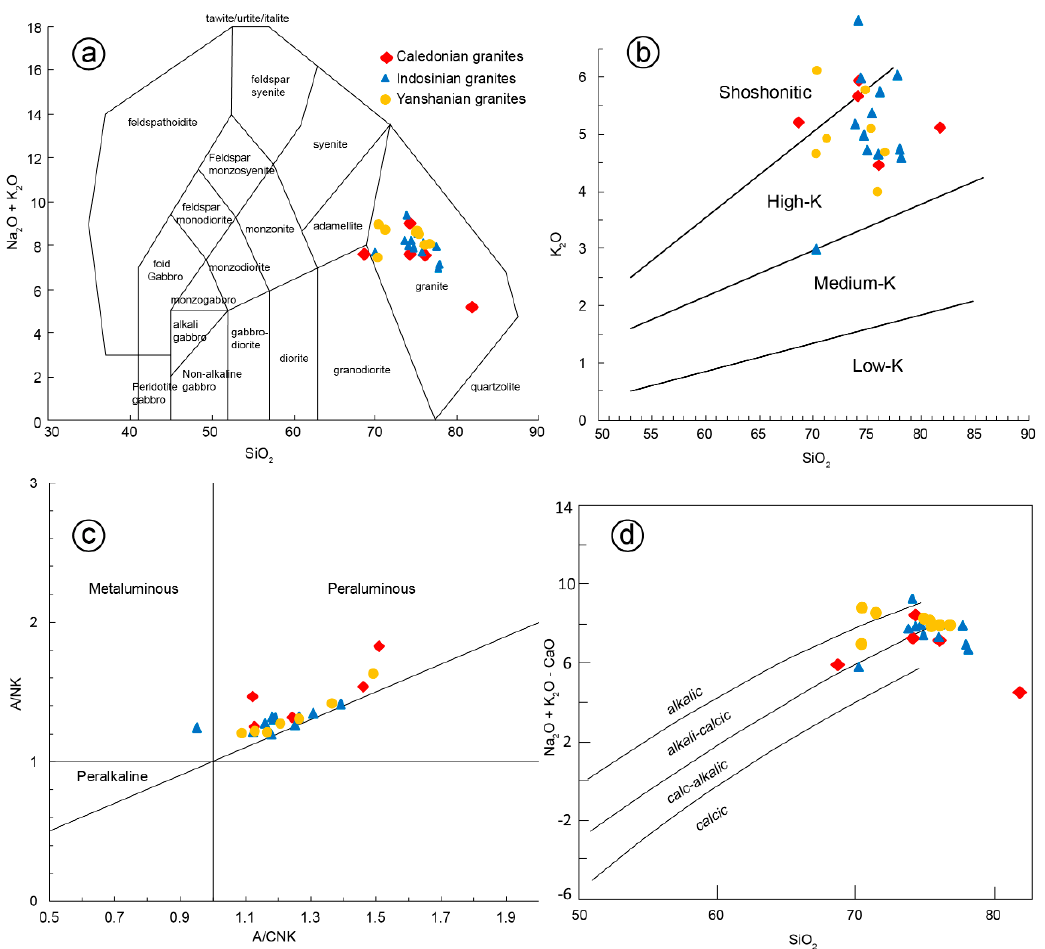
Figure 14. Plots of ( a ) Na 2 O + K 2 O versus SiO 2 , ( b ) K 2 O versus SiO 2 , ( c ) A/NK [molar ratio Al 2 O 3 /(Na 2 O + K 2 O)] versus A/CNK [Al 2 O 3 /(CaO + Na 2 O + K 2 O)] [46] and ( d ) Na 2 O + K 2 O-CaO versus SiO 2 for the various granites from the Taoxi dome. The diagram in ( a ) is from Middlemost (1994) [42], ( d ) is from Frost et al. (2001) [43].